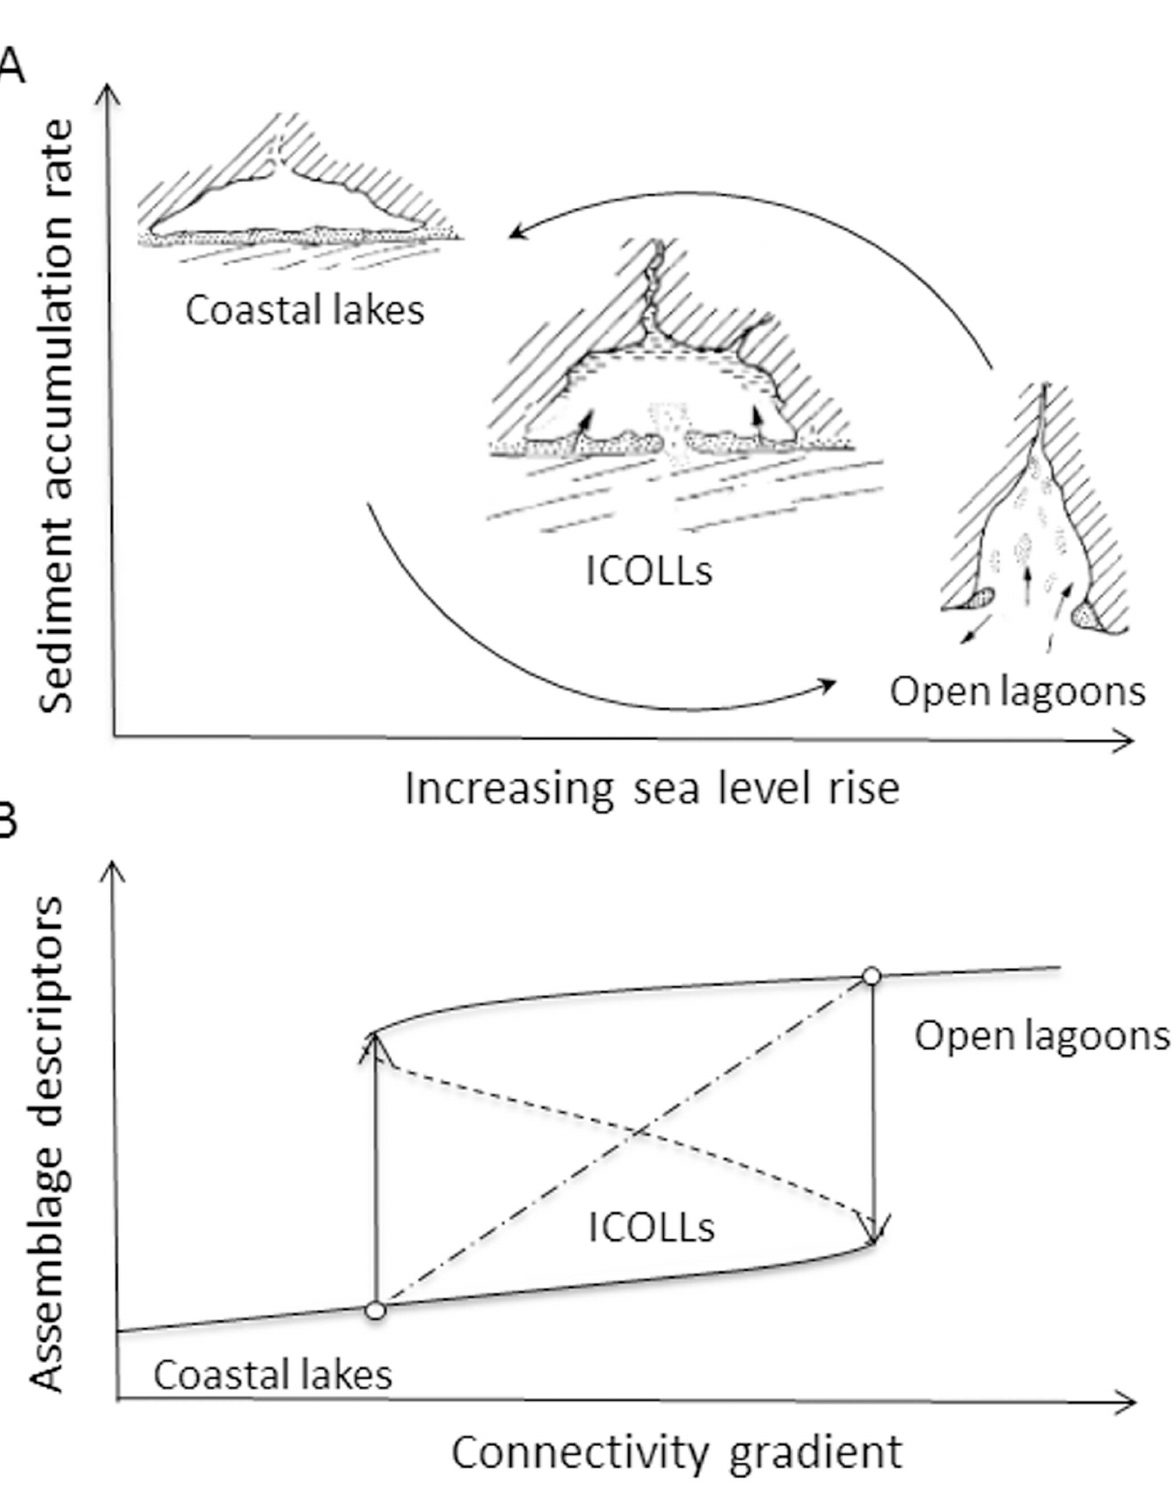
Fig 1. Conceptual model of coastal lagoon evolution based on the relative importance of sedimentation, river inflow and tide (A) and the model showing the transition between the two alternative stable states of coastal lagoons along a connectivity gradient